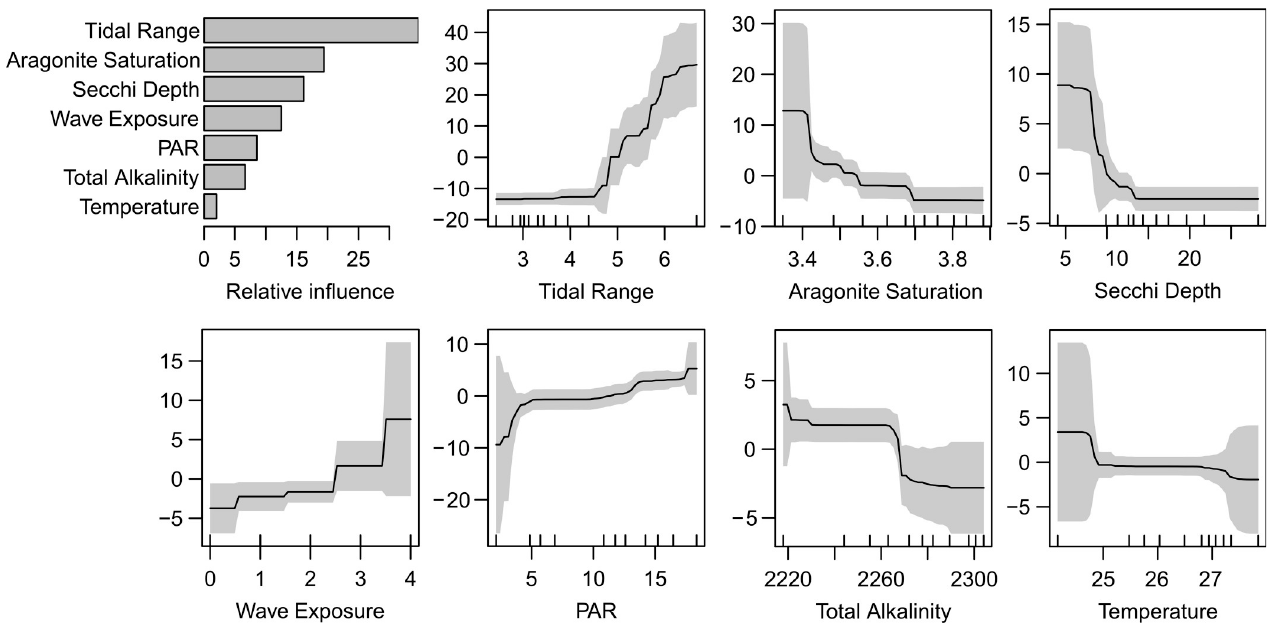
Fig 4. Total macroalgal cover (MA) in response to long-term mean environmental conditions. Partial dependence plots, showing the relative influence (percentage contribution) of each predictor, and the changes in MA to the predictors (solid lines), and their 95% confidence intervals (grey envelopes). The y- axis represents the change in MA relative to the global mean (9.3% cover) attributable to each predictor. The ticks on the x-axis show the deciles of the predictors’ data distributions. Definitions and units of the predictors in S1 Table in S1